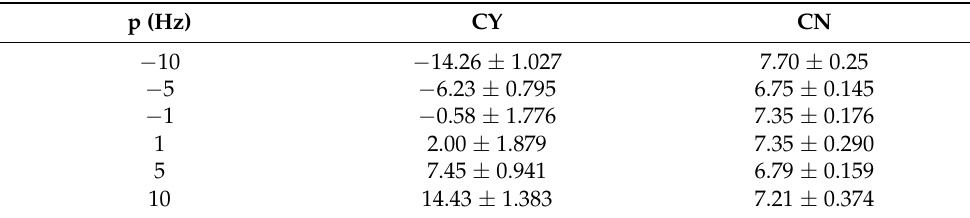
Table 3. Averaged side and normal force coefficients versus spin velocity at Ma = 0.2, Re = 2 × 10 6 and α = 45